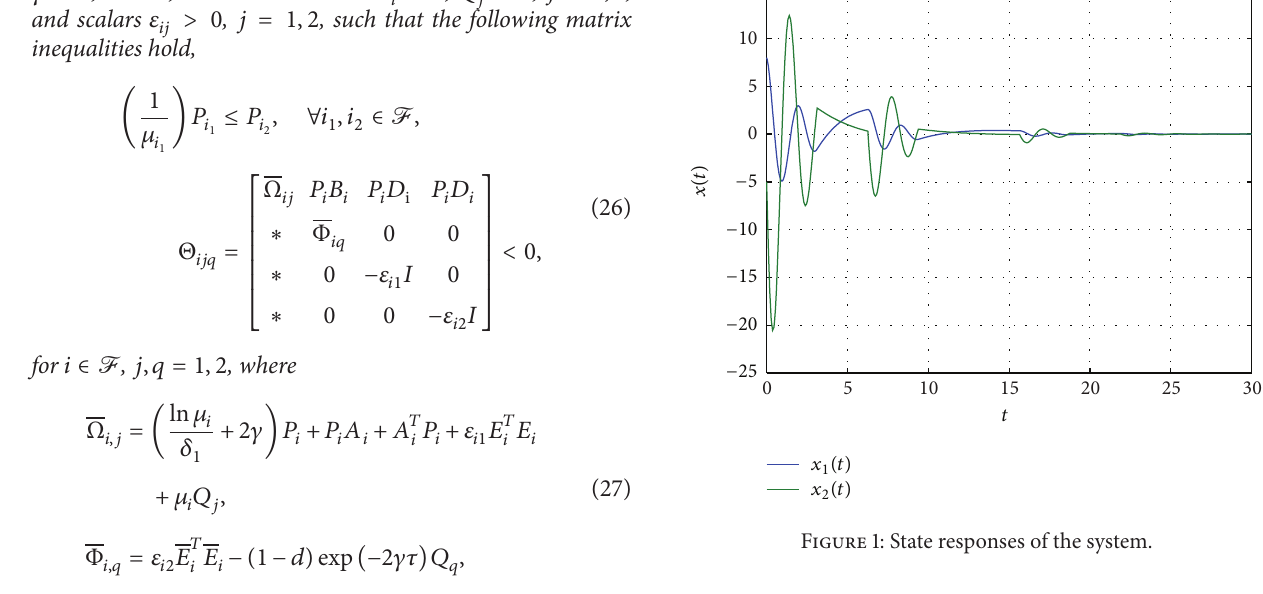
Figure 1: State responses of the